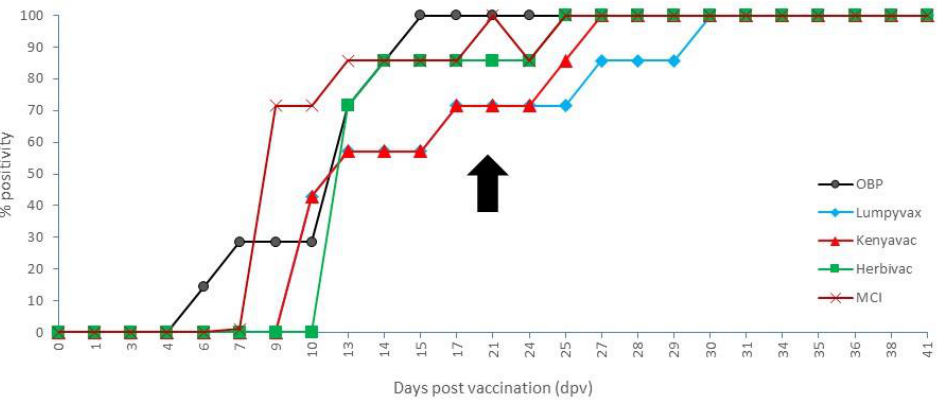
Figure 8. IPMA results of the vaccinated animals. Black arrow: day of challenge. seen with VNT1, namely, between 10 (Lumpyvax) and 17 dpv (Kenyavac). However,